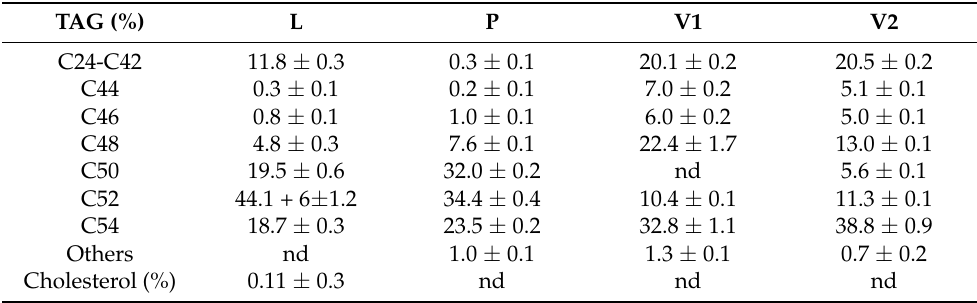
Table 3. Triacylglycerol (TAG) compositions and cholesterol contents (mean ±SD) of the fat blends L, P, V1, and V2 (for identification of the samples see Table 1).